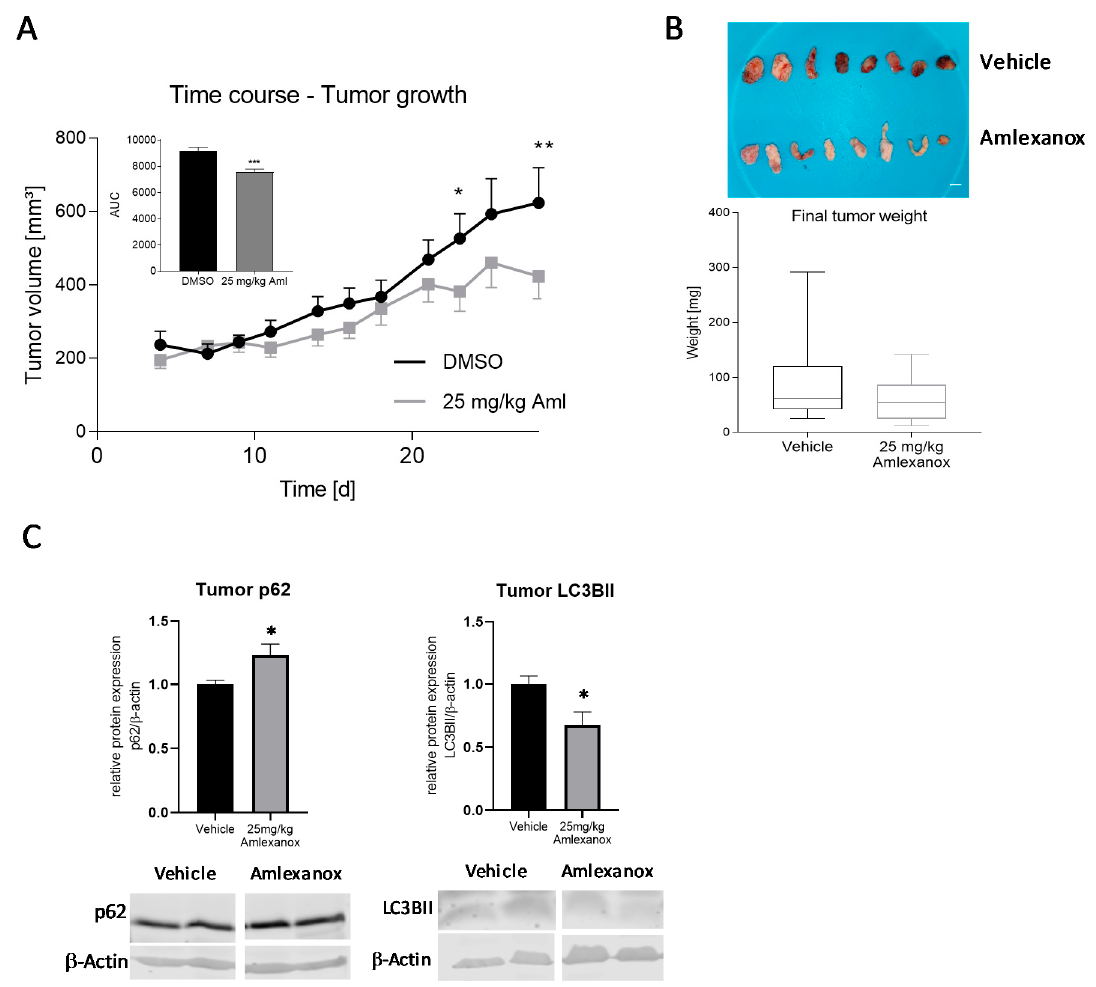
Figure 8. Effects of amlexanox in the nude mice xenograft model. ( A ) Time course of the tumor growth after subcutaneous injection of SK-Mel-28 cells into the flanks of nude mice. The tumor size in mice treated with vehicle (DMSO) ( ● ) or amlexanox (25 mg/kg body weight, p.o.) ( ■ ), respectively, was measured every third day until 28 days after injection. The inserted bar graph shows the calculation of the area under the tumor volume vs. time curve (AUC). ( B ) Determination of the tumor weight of the dissected tumor at 28 days ( n = 12–18 mice/group). Scale Bar: 5mm ( C ) LC3B-II and p62 expression in the tumors of nude mice after treatment with amlexanox or vehicle (DMSO). The Western blots show two representative samples; the bar diagrams show the densitometric analysis of all samples ( n = 5–6). * p < 0.05, ** p < 0.01, in comparison to the vehicle-treated control cells. * p < 0.05, ** p < 0.01, in comparison to vehicle-treated mice.